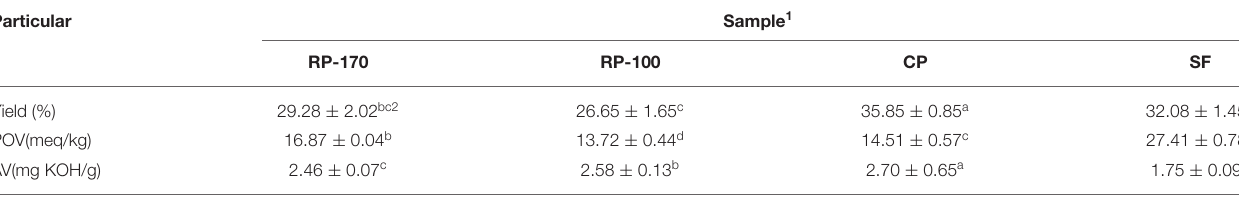
TABLE 1 | Yield, peroxide value (POV), and acid value (AV) of lemon seed oil extracted using different methods. Particular